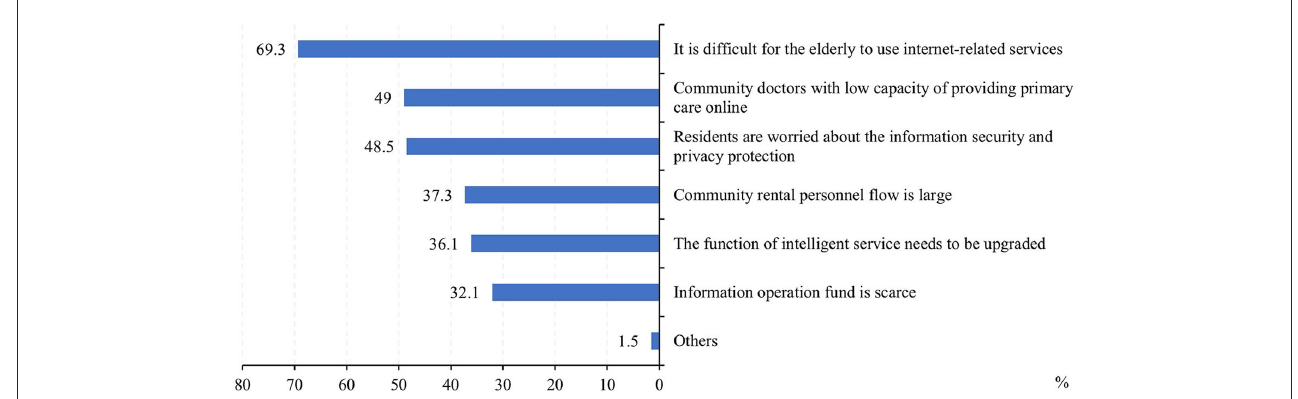
FIGURE4 Reported challenges faced by Internet-based healthcare services in primary health